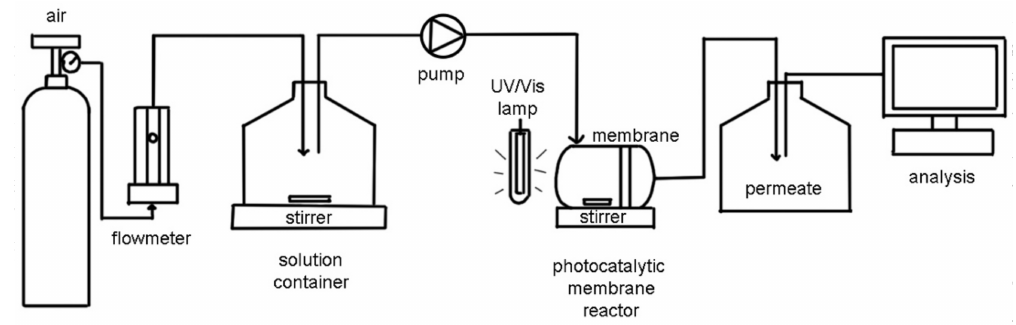
Figure 7. PMR equipped with a polymer membrane with photocatalytically active separation layer [134].